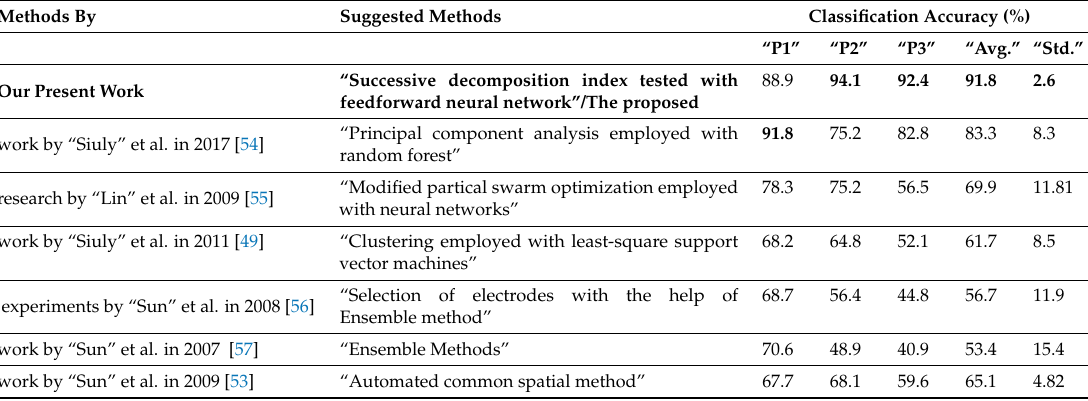
Table 8. Performance comparison of mental imagery EEG signals in terms of classification accuracy (%) with other